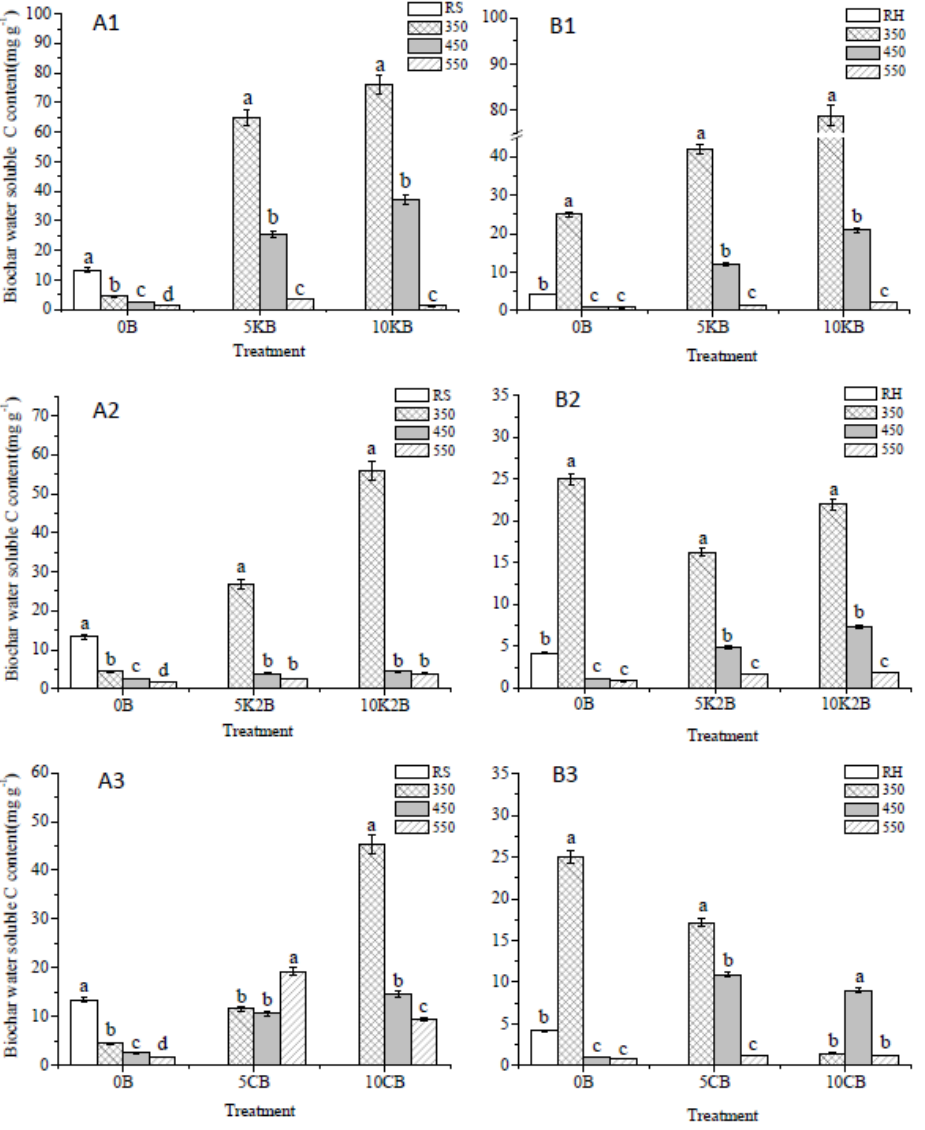
Figure 2. Water soluble C content of alkali-enhanced ( A ) rice straw and ( B ) husk biochar pre- pared at different pyrolysis temperatures. Note: In the figure, subgraph ( A1 – A3 , B1 – B3 ) indi- cates KOH, K 2 CO 3 , and CaO of alkali treatments of rice straw (RS) and rice husk (RH), respec- tively; 0B, 5KB/K2B/CB, and 10KB/K2B/CB indicate the biochars prepared at the proportion of KOH/K 2 CO 3 /CaO to feedstock of 0:100, 5:100, and 10:100. Here, 350, 450, and 550 ◦ C indicate the pyrolysis temperatures. Different letters indicate significant differences within treatment ( p < 0.05) based on Duncan’s multiple range